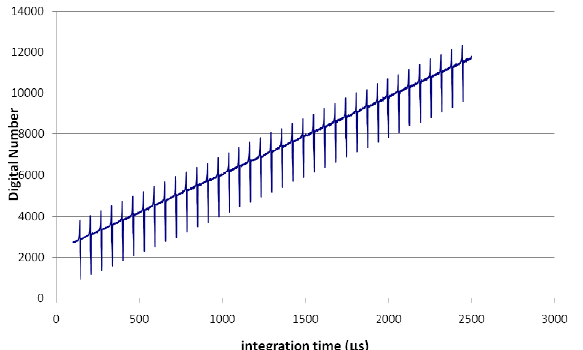
Figure 3. Image digital value (output) versus the integration time at a constant scene illumination (input) for the XEVA XS-